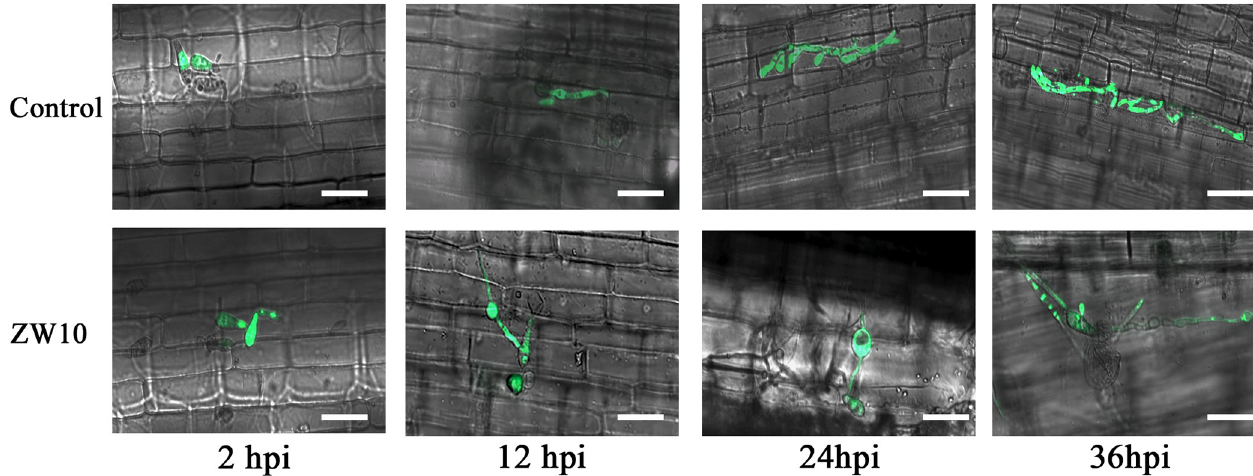
Fig 4. The antifungal substances of ZW10 were antagonistic to M . oryzae in vivo . After the treatment with 1% CFB of ZW10 treatment, the capacity of M . oryzae mycospores to infect epidermal cells of leaf sheath was altered. Scale bar, 20 μ m.